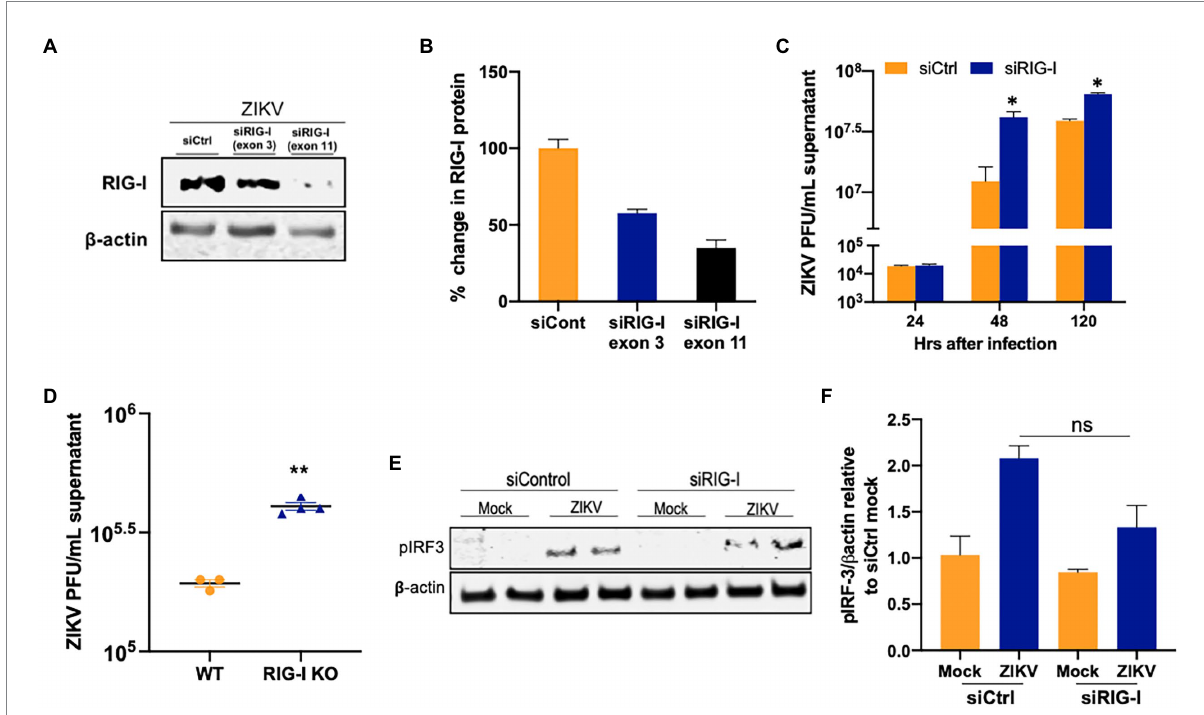
FIGURE 3 RIG-I restricts ZIKV replication in human SC. (A,B) SC were transfected with either siCtrl or siRNA specific to exon 3 or exon 11 of RIG-I. The silencing efficiency was determined by measuring RIG-I protein levels using Western blot at 48 hpt transfection. (C) SC were infected with ZIKV (MOI 1) at 48 hpt and ZIKV titers was quantified using plaque assay at different time points. (D) Wild-type (WT) and RIG-I knock-out A549 were infected with ZIKV (MOI 1) and virus titers in the supernatants were determined by plaque assay at 48 hpi and expressed as PFU/mL supernatant. (E) Whole-cell extracts from uninfected and infected SC transfected with siCtrl, and siRIG-I (exon 11) at 48 hpi with ZIKV were subjected to Western blotting and stained for p-IRF3 and β -actin. (F) Densitometry analysis was performed using ImageJ and the p-IRF3/ β -actin ratio in infected cells relative to the siCtrl mock was calculated. Data is presented as mean ± SEM from at least 3–5 independent experiments. * p < 0.05; ** p <